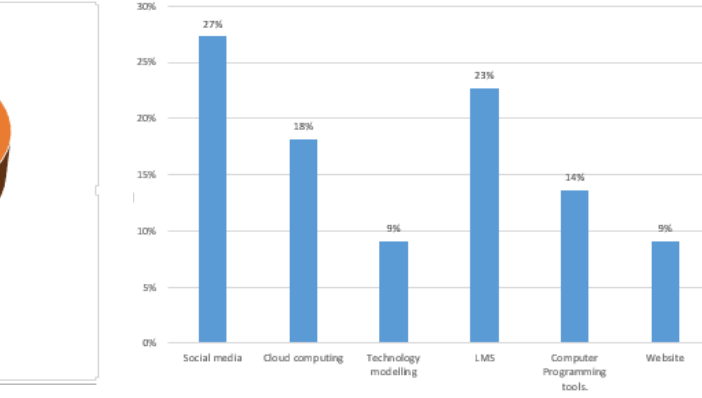
Figure 2: Background of the studies